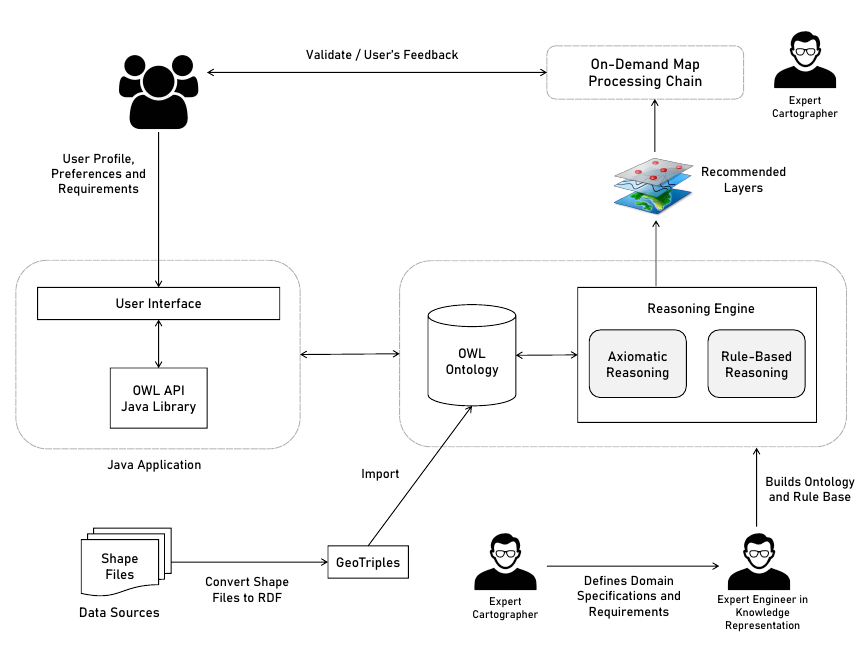
Figure 5. Architecture framework for the recommendation of thematic